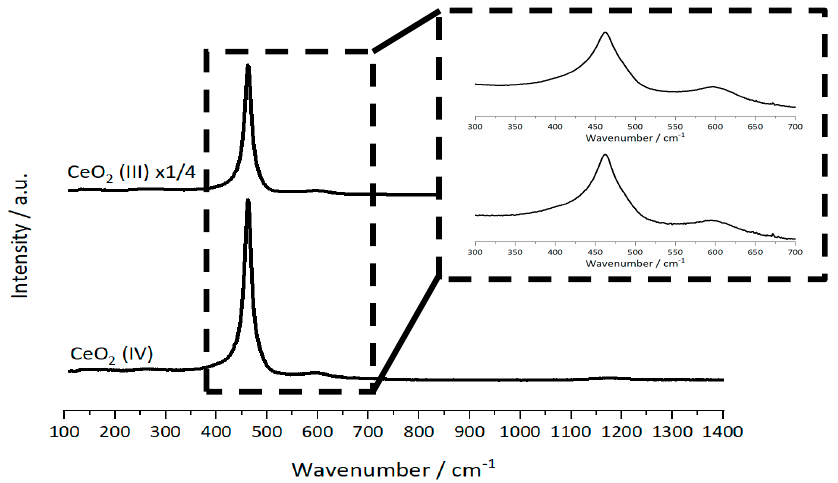
Figure 7. Laser Raman Spectra of the CeO 2 catalysts. Inset shows band relating to de- fects.